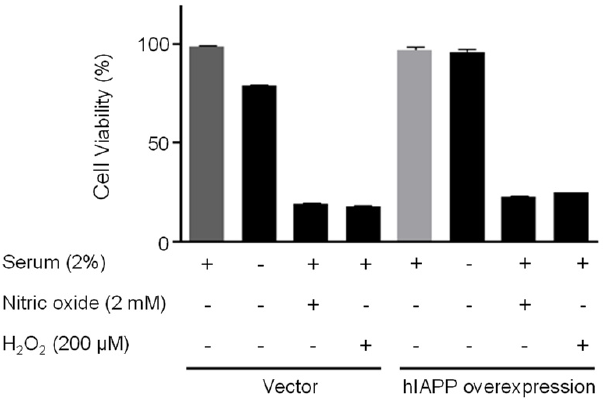
Figure 5. Cell viability in pCMV-Entry-expressing cells and INS1E-hIAPP-overexpressing cells under oxidative stress conditions. INS-1E cells were incubated in RPMI 1640 medium supplemented with/without 2% fetal bovine serum and/or nitric oxide (2 mM) or hydrogen peroxide (200 µ M) for 24 h at 37 ◦ C with 5% CO 2 . Cell viability was analyzed by Cell Counting Kit-8. Values are presented as the mean ± SEM of three